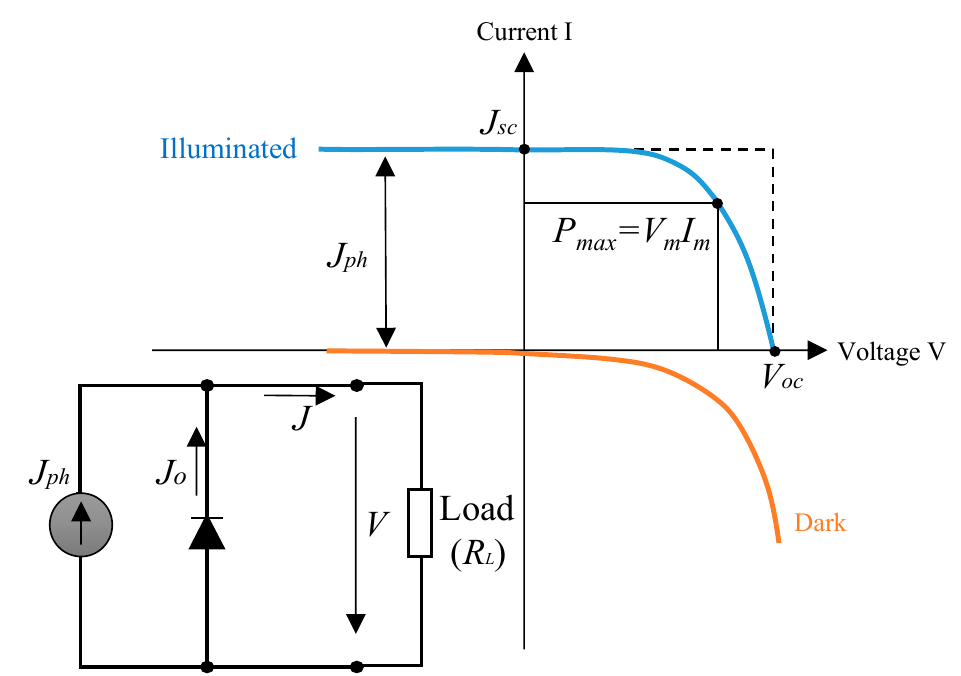
Figure 2. The equivalent circuit and IV characteristics of dark cell when J ph = 0. All radiated photons must be fully absorbed and converted into photocurrent to achieve a maximum J ph . In this context, the external quantum efficiency ( EQE ) defines the photon-to-photocurrent conversion efficiency of a TPV cell. EQE( λ ) as a function of λ describes the probability of a photon with wavelength λ absorbed by the cell which generates electron-hole pair that will be collected at the terminal. EQE( λ ) represents the functionality of p-n junction in detail as it considers both the reflection and absorption coefficient of the incident photon as well as the collection of the minority carriers. EQE can be solved from J sc , which is expressed as a function of incident photon flux Φ ( λ ) given by: